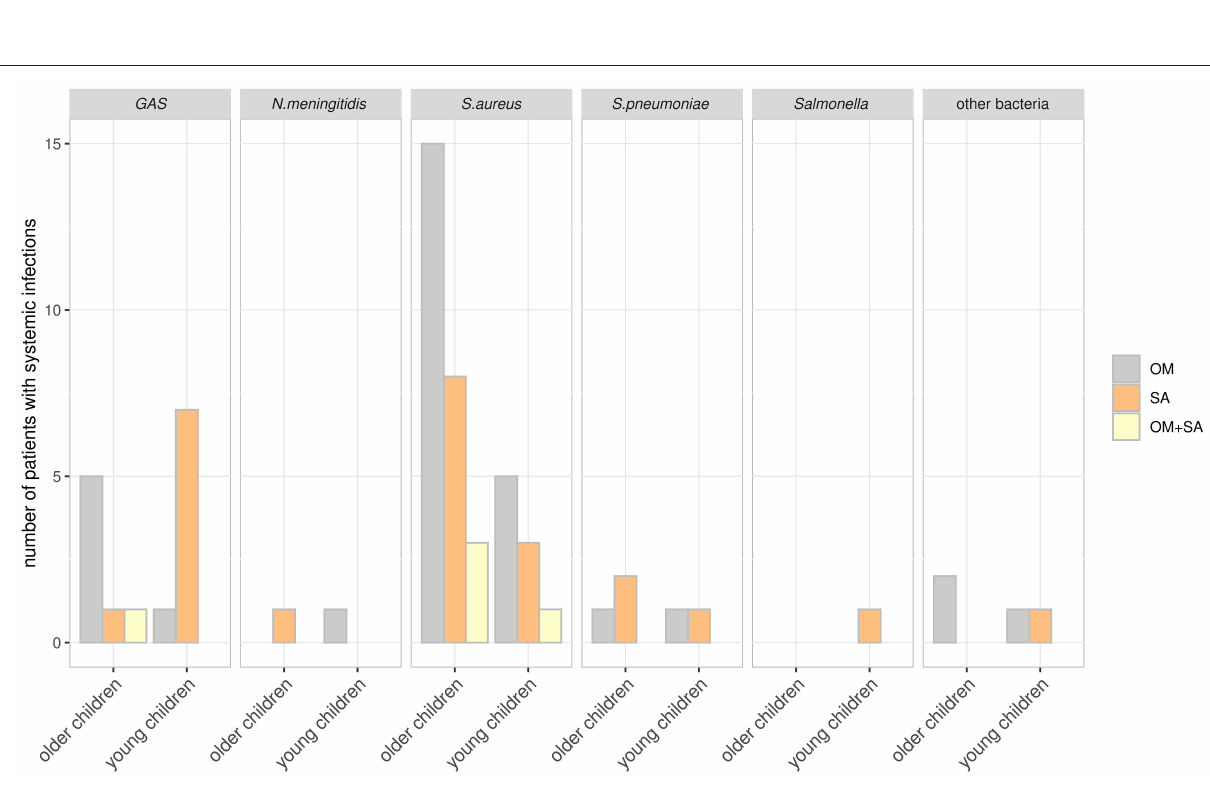
Frontiers in Pediatrics |